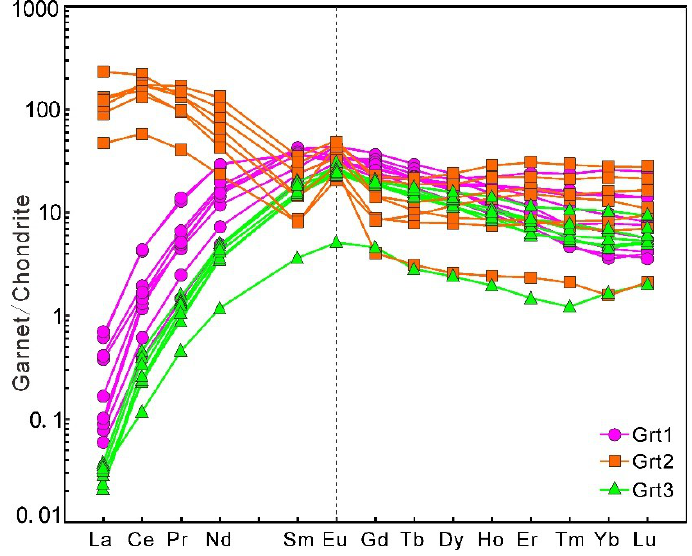
Figure 13. Chondrite-normalized rare earth element (REE) distribution patterns for three generations of garnets from the Yamansu deposit. The chondrite-normalized values were calculated by [35]. Grt2 have the highest Σ REE (75.28–250.62 ppm) contents and variable Σ